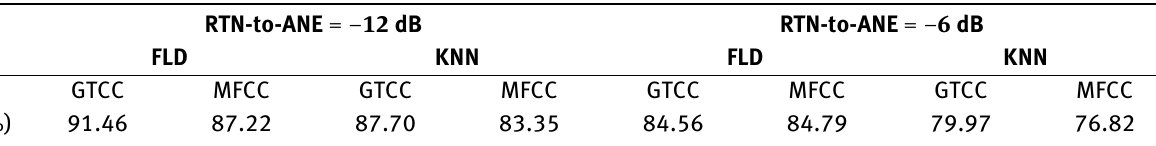
Table 3: Recognition accuracy of the ANED algorithm using different classifiers (FLD and KNN) and audio feature extraction techniques (GTCC and MFCC) under − 12 dB and − 6 dB RTN-to-ANE ratio scenarios.